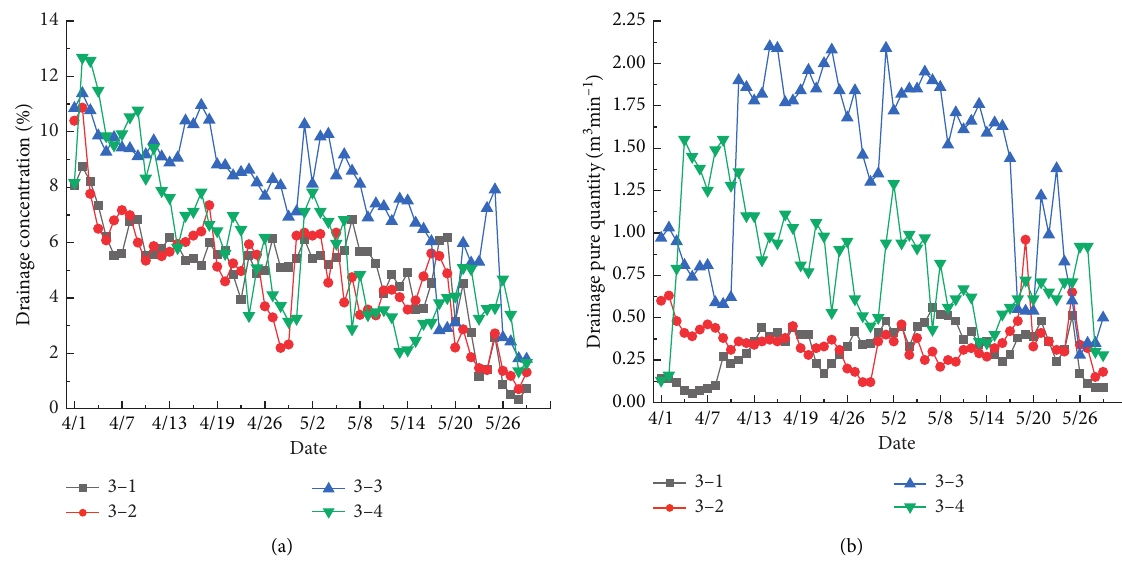
Figure 14: Extraction effect of #3 high directional long borehole. (a) Drainage concentration. (b) Drainage pure quantity.